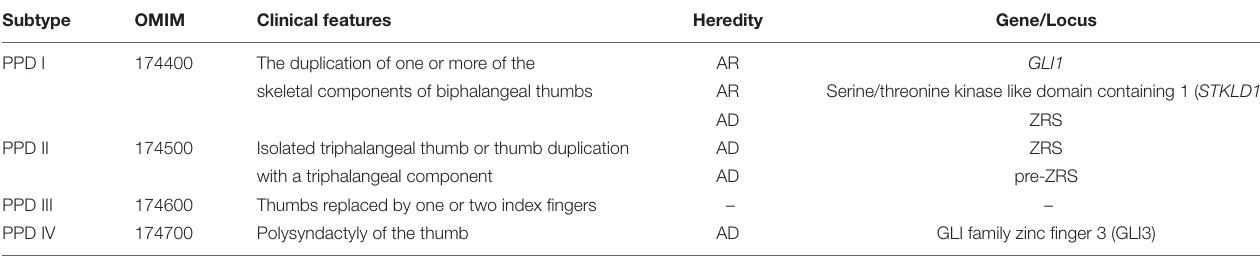
TABLE 1 | Classification of PPD and their clinical features and causative